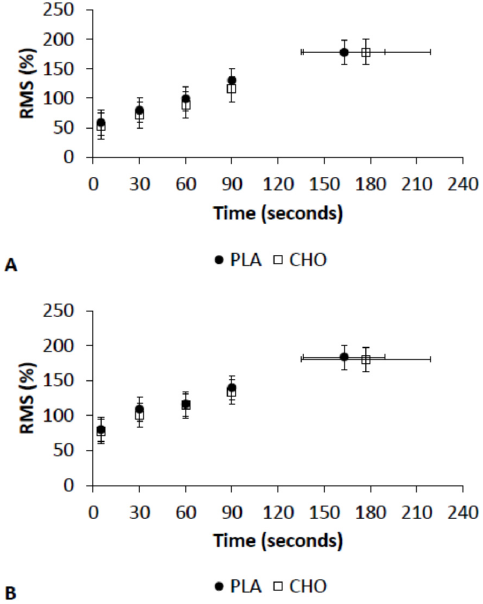
Figure 3. EMG activity during high ‐ intensity exercise in ( A ) rectus femoris (RF); and ( B ) vastus lateralis (VL). Root mean square (RMS) was used as an indicator of total muscle activation.